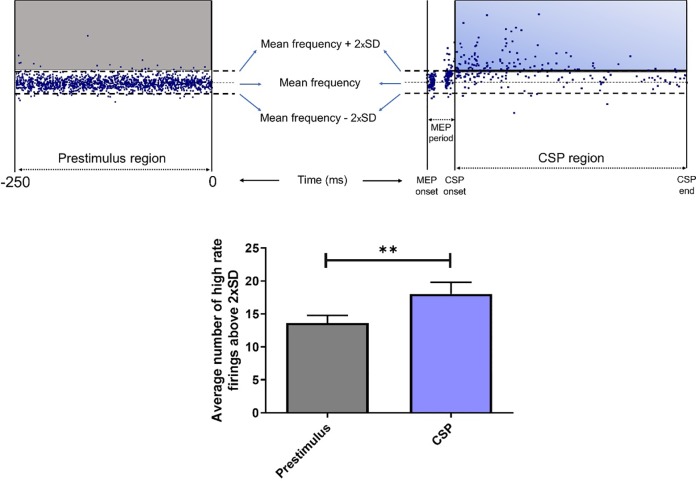
Average number of units firing above 2xSD for different TMS intensities at prestimulus region and early poststimulus region (CSP) in TA muscle.The number of high-frequency firings during prestimulus time of 250 ms (top left figure, units in gray rectangular shape) was compared with the average number of high-frequency firings at the CSP region (top right figure, units in blue rectangular shape) after normalization to 100 ms (see text for details). The average number of high-frequency events at prestimulus and CSP regions for 29 units are shown in gray and blue column at the bottom, respectively **p<0.01. Error bars are SEM and N = 29.